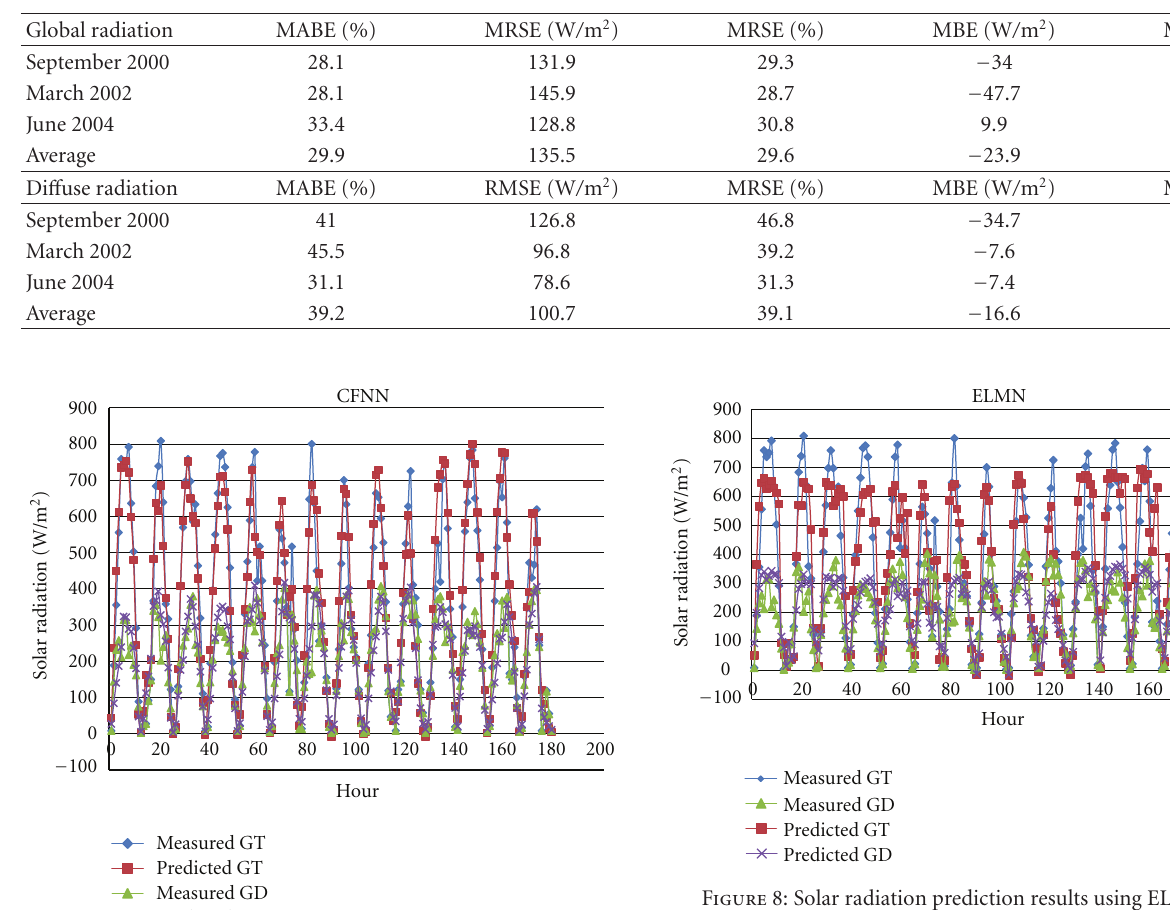
Table 4: Evaluation statistics for ELMNN.